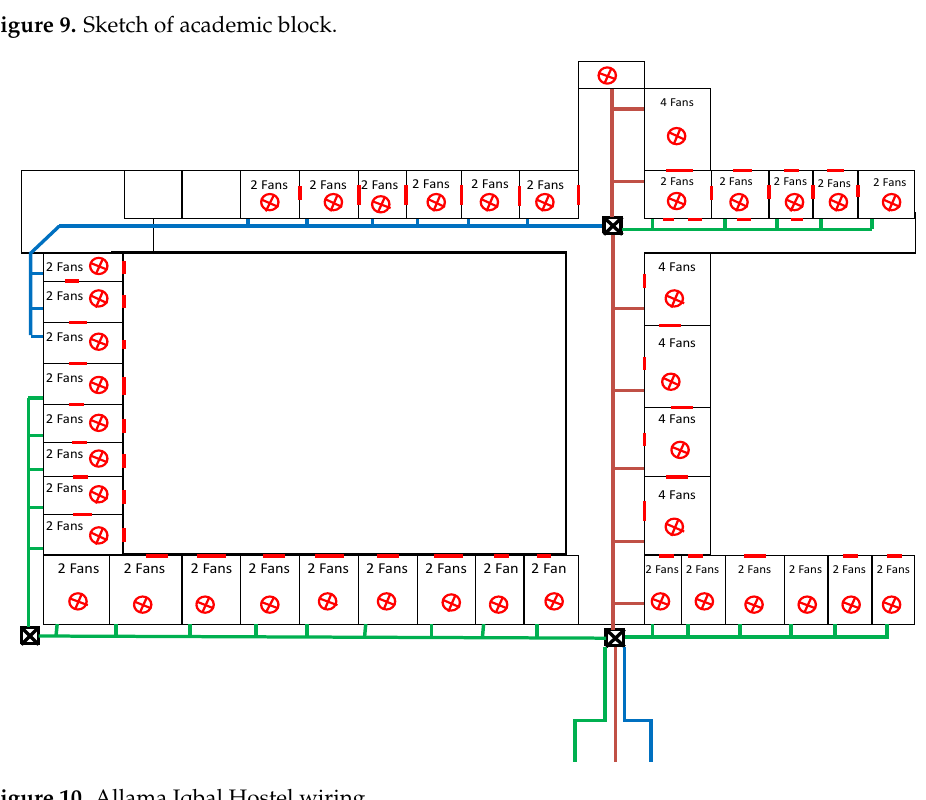
Figure 10. Allama Iqbal Hostel